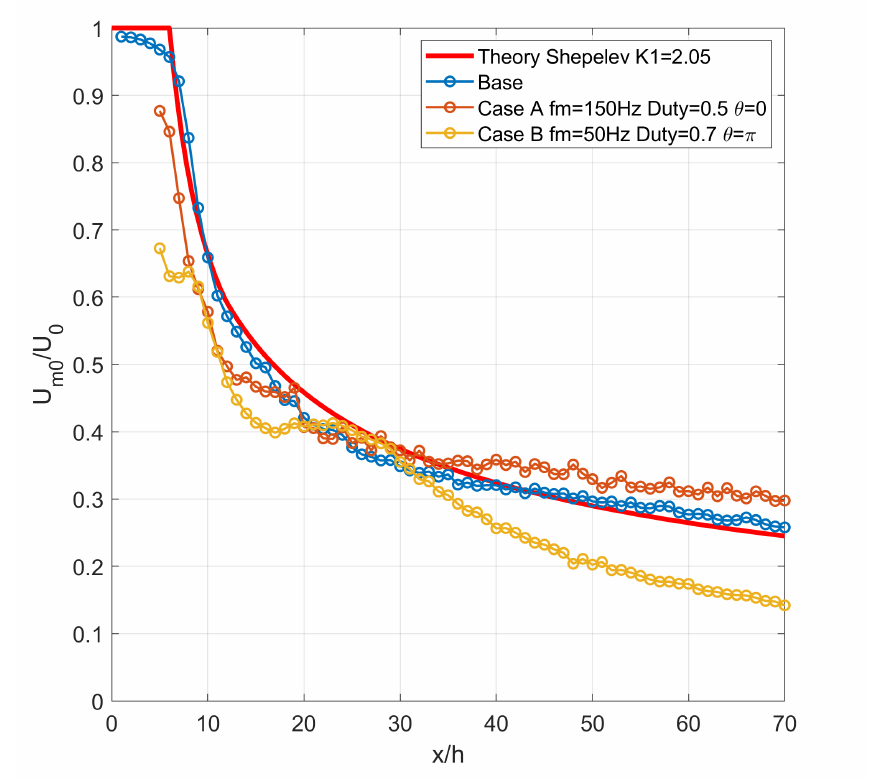
Figure 14. Comparison between centerline velocities of different